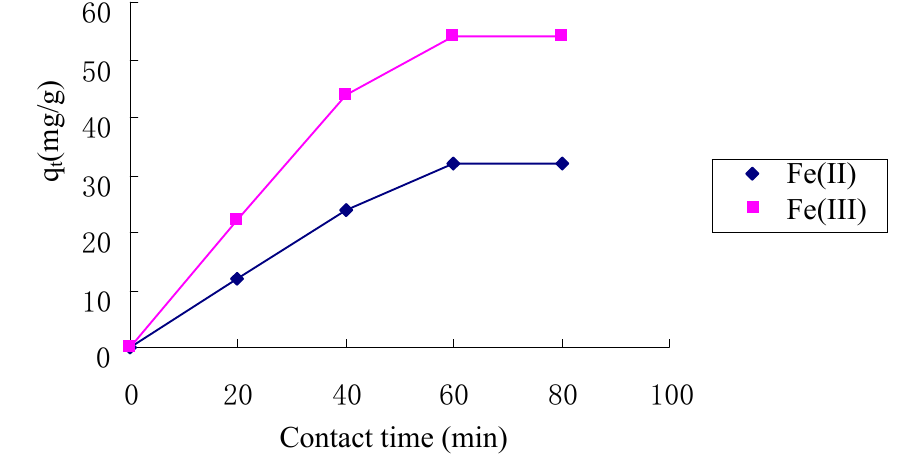
Figure 4. Effect of contact time on adsorption of Fe(II) and Fe(III).